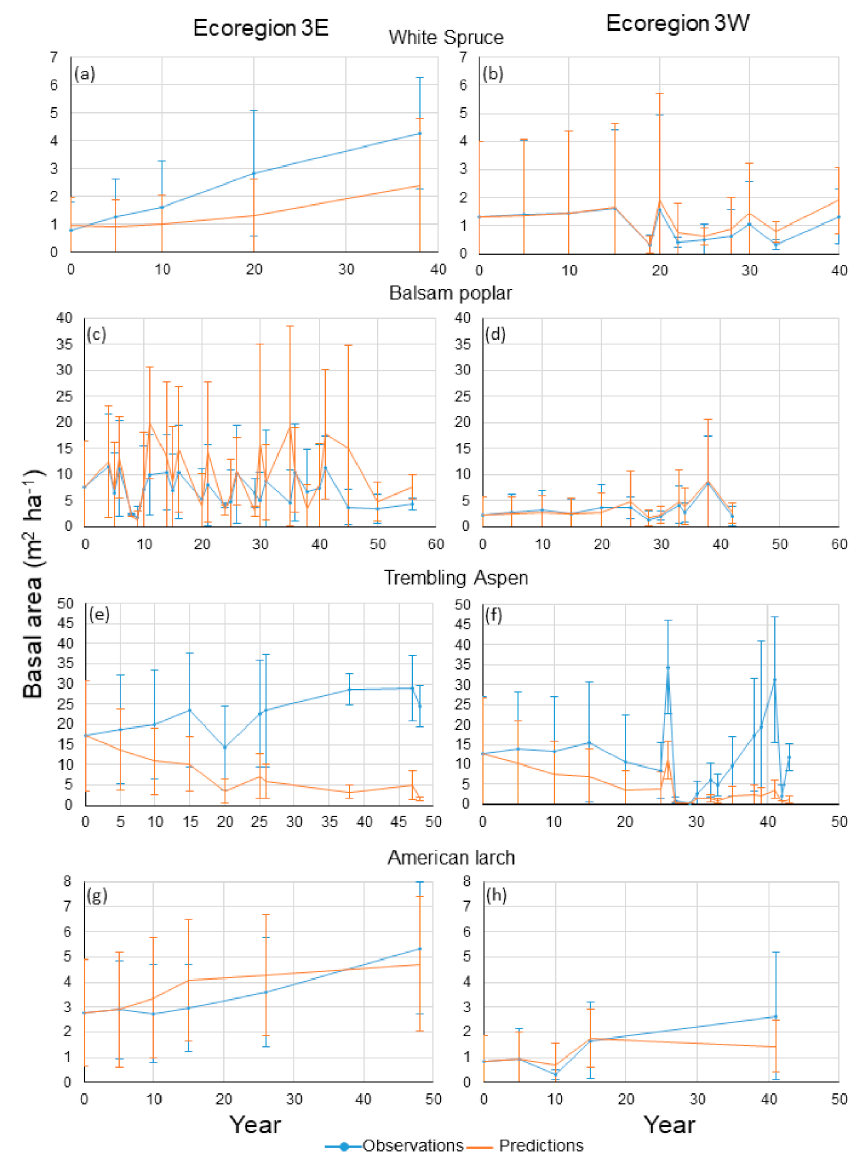
Figure 4. Comparisons between mean observed and predicted basal areas for white spruce ( a , b ), balsam poplar ( c , d ), trembling aspen ( e , f ) and American larch ( g , h ) over years in ecoregions 3E and 3W of the boreal forest region of northern Ontario, Canada. Error bars are standard